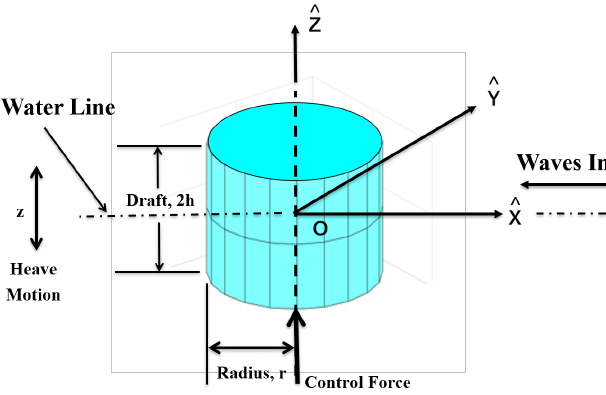
Figure 1. Right circular cylinder (RCC) wave energy converter (WEC) buoy